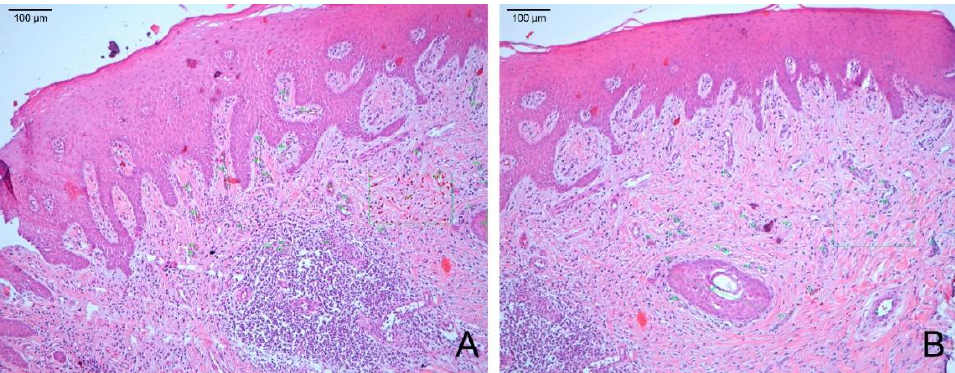
Figure 8. ( A ) Microphotography of the sample treated with an acellular dermal matrix at 90 days (100×). ( B ) Microphotography of the sample treated with subepithelial autogenous connective tissue at 90 days (100×).